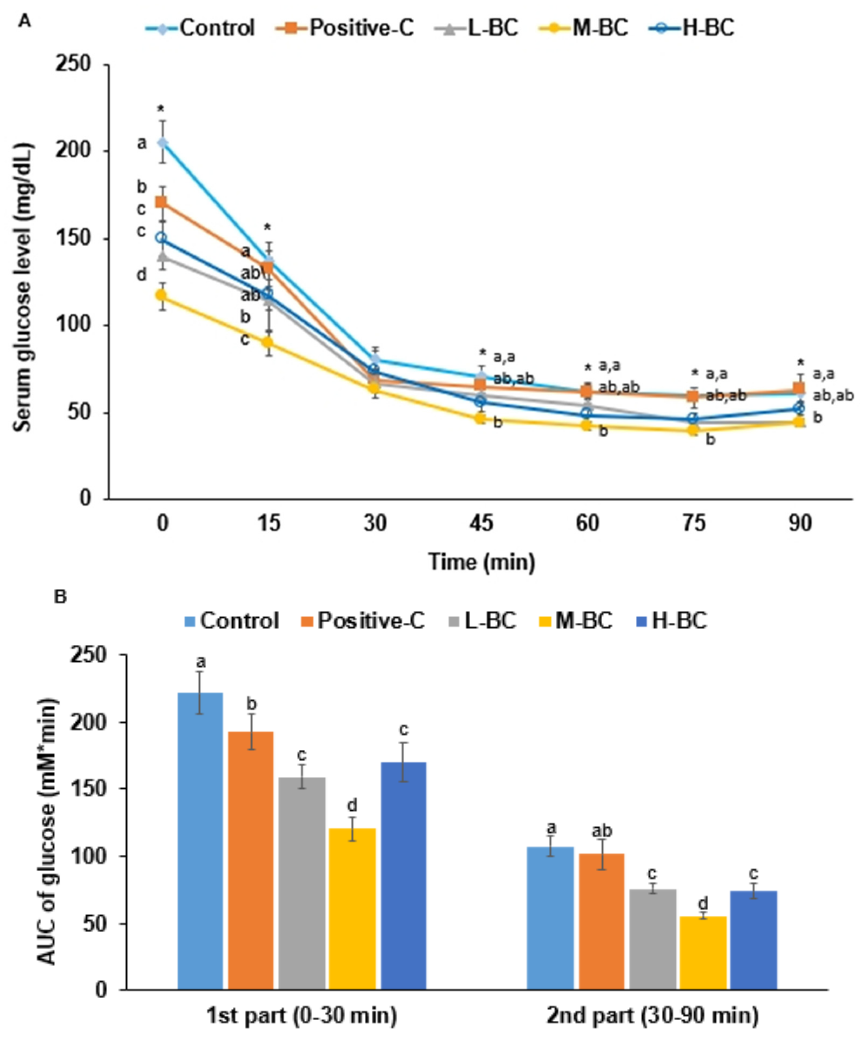
Figure 3. Changes and area under the curve (AUC) of serum glucose concentrations during intraperitoneal insulin tolerance testing (IPITT). Partially pancreatectomized (Px) rats were fed a high-fat diet supplemented with 0% (control), 0.2% (L-BC; low dosage), 0.6% (M-BC; medium dosage), and 1.8% (H-BC; high dosage) blackcurrant extracts; 0.2% metformin (positive-C); plus 1.8%, 1.6%, 1.2%, 0%, and 1.6% indigestible dextrin. After 6 h of food deprivation at two days after OGTT, IPITT was conducted by intraperitoneal (IP) injection of 0.75 IU insulin/kg body weight followed by measurement of serum glucose concentrations in tail blood every 15 min for 90 min. ( A ). The AUC for serum glucose during the first 0 to 30 min and 30 to 90 min ( B ). Each dot/ bar and error bar represents a mean and standard deviation, respectively ( n = 10). * Significantly different among the groups ( p < 0.05). a,b,c,d Different letters on bars or lines indicate significant differences among the groups at p < 0.05. Table 3. The β -cell mass and β -cell proliferation and apoptosis at eight-week intervention. Control ( n = 5) β -cell area